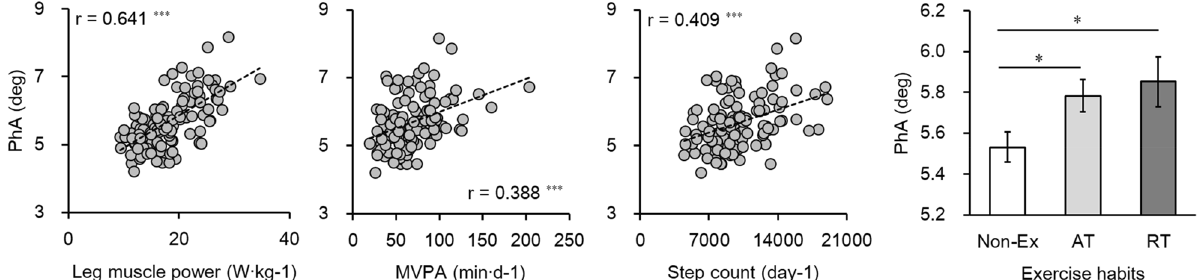
Figure 1. Relationship between leg muscle power, moderate-to-vigorous physical activity (MVPA), step count, or exercise habits with phase angle (PhA). *Significant difference between group P <